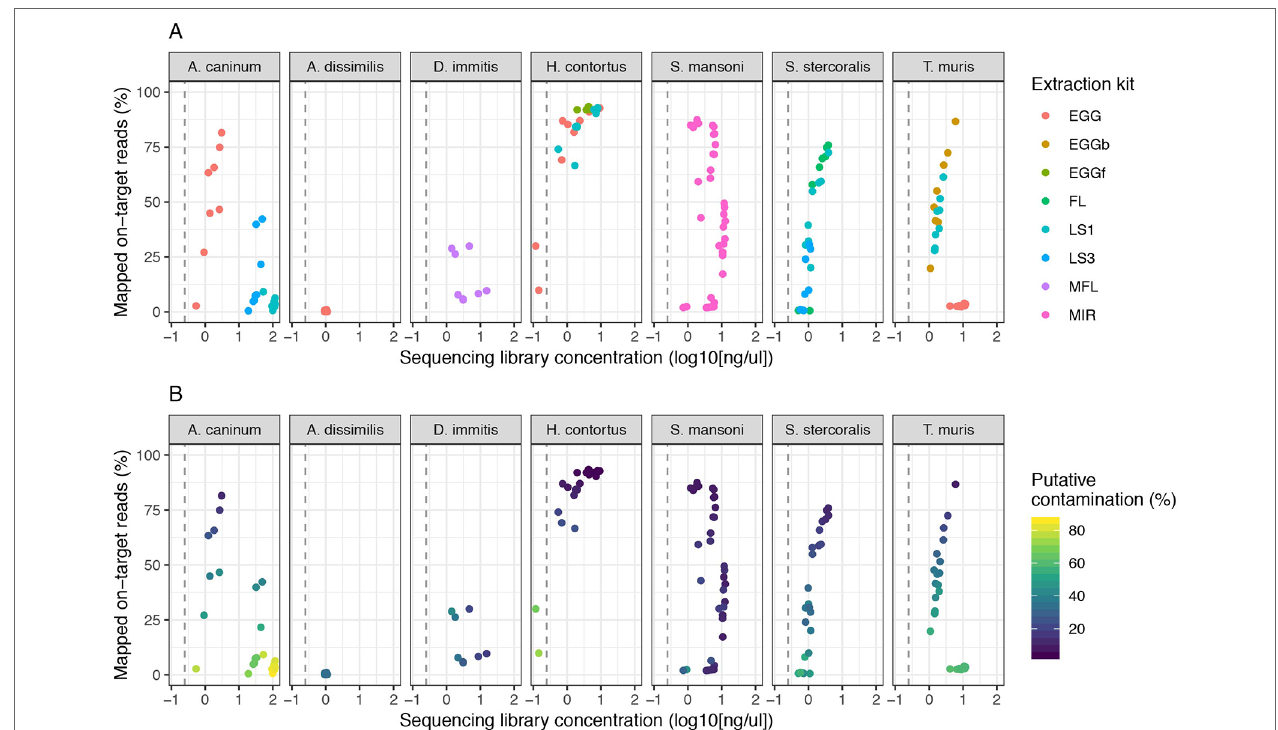
FIGURE 3 | Impact of sequencing library concentration on mapped on-target reads from multiple life stages of seven helminth species. Each point represents an individual sequencing library samples, colored by life stage (A) or proportion of putative contaminating reads (100 - percent_unclassified_reads) (B) . DNA was extracted from all samples using the CGP protocol. Consistent with Figure 2 , the dashed grey vertical line represents 0.25 ng/µl. Egg, untreated egg; EGGb, bleached egg; EGGf, frozen egg; FL, full-length female; LS1, larval stage L1; LS3, larval stage L3; MFL, microfilaria; MIR, miracidia. The number of samples in each comparison is presented in Table 1